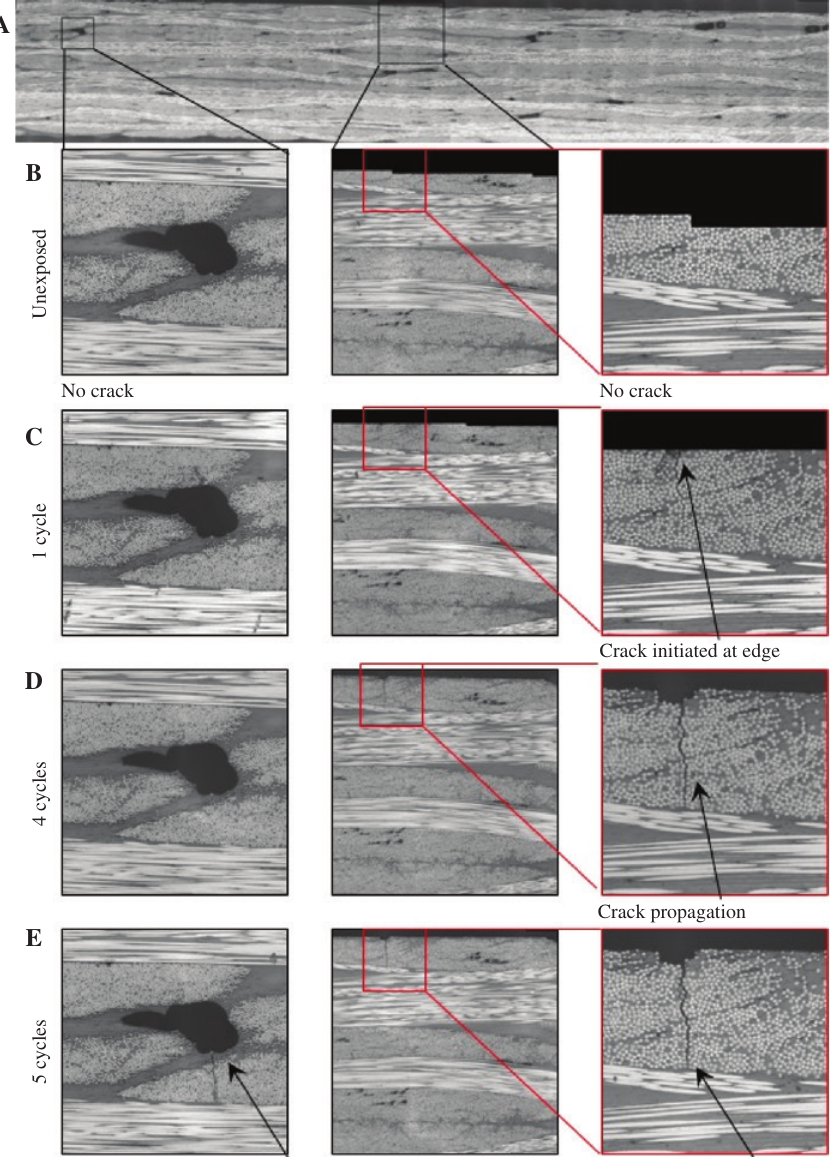
Figure 2: The results of the microscopy for the cross-ply fabric for the first five cycles. (A) Optical microscopy image of the cross-ply fabric laminate; (B) before exposure to thermal cycle; (C) after one cycle; (D) after four cycles; (E) after five cycles. Crack imitation and propagation around the void and close to edge are